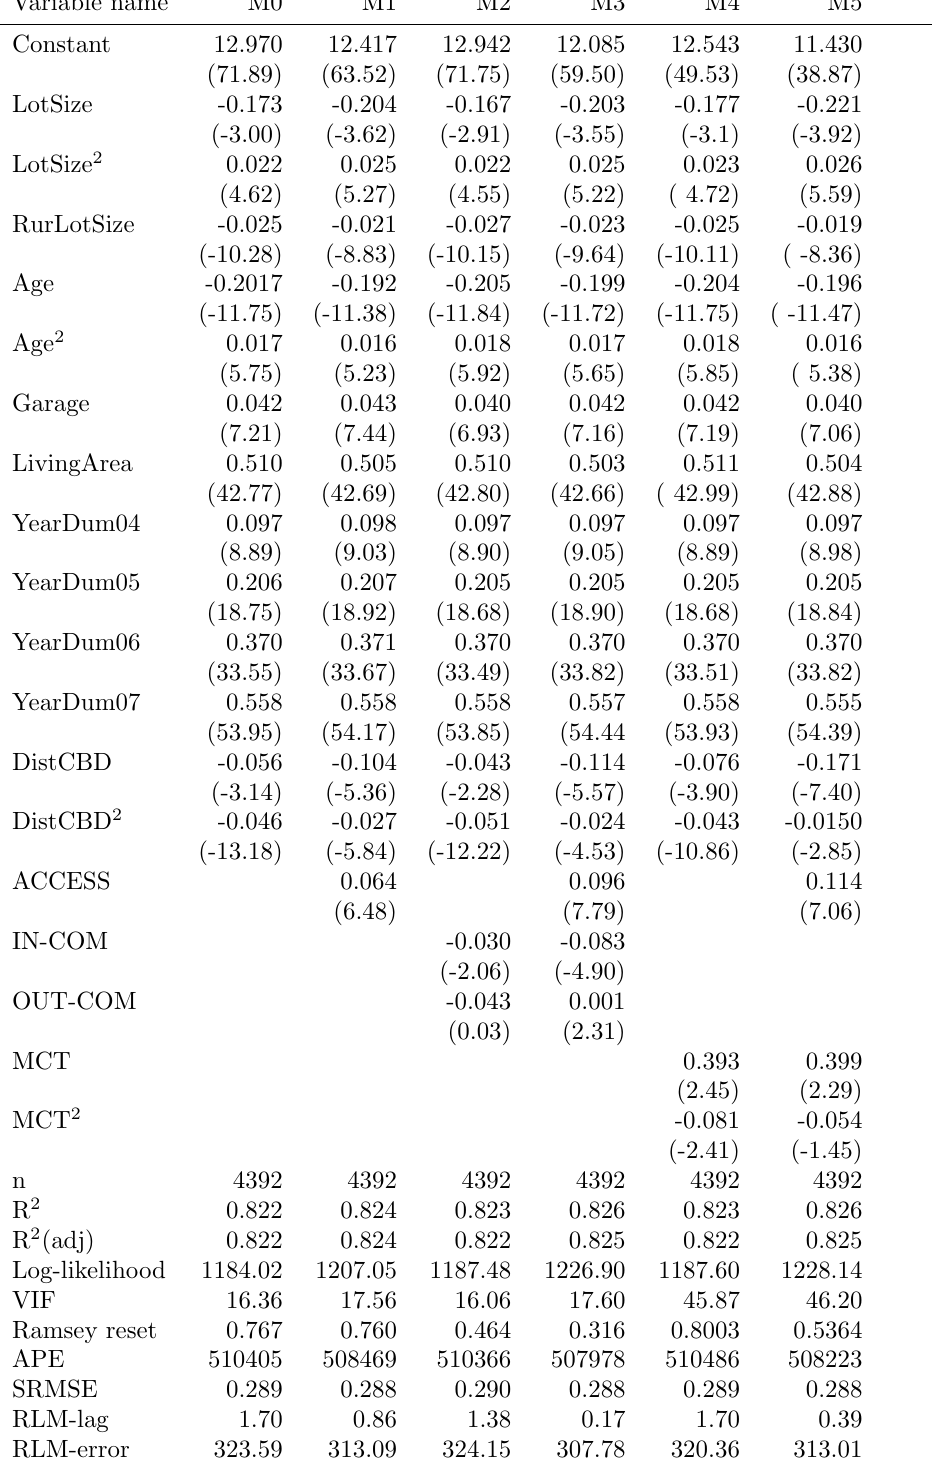
Table 2: Estimated results from alternative hedonic house price